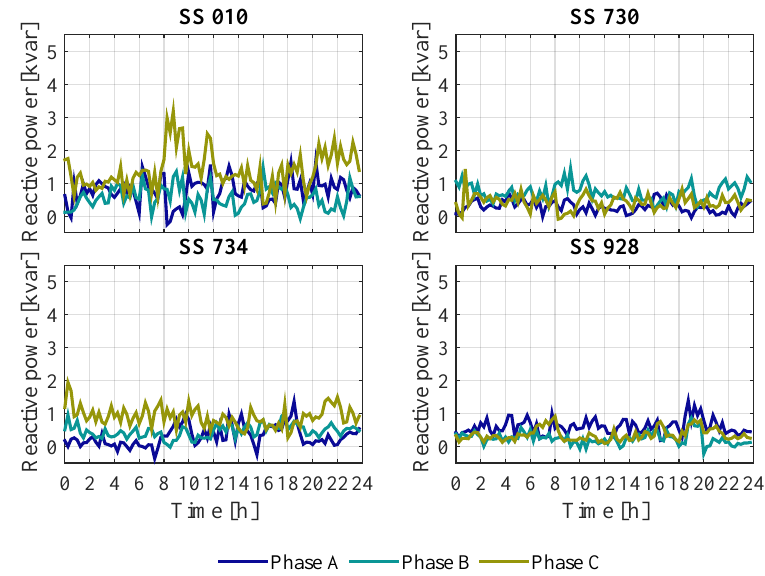
Figure 9. Reactive power demand profile for phases A, B and C at each SS for all